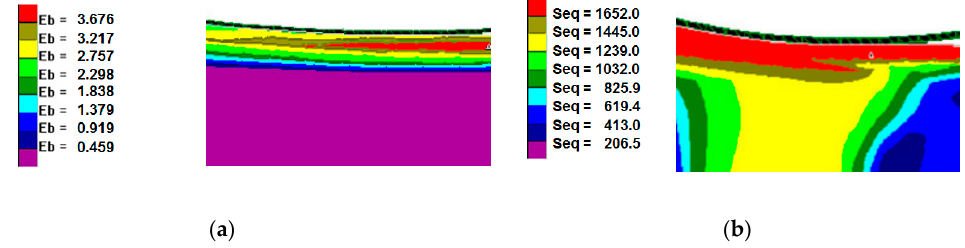
Figure 8. State of strain and stress in the Ni–5%Al coating after the burnishing process for a 0.6 mm coating thickness: ( a ) strain intensity; ( b ) stress intensity in MPa.